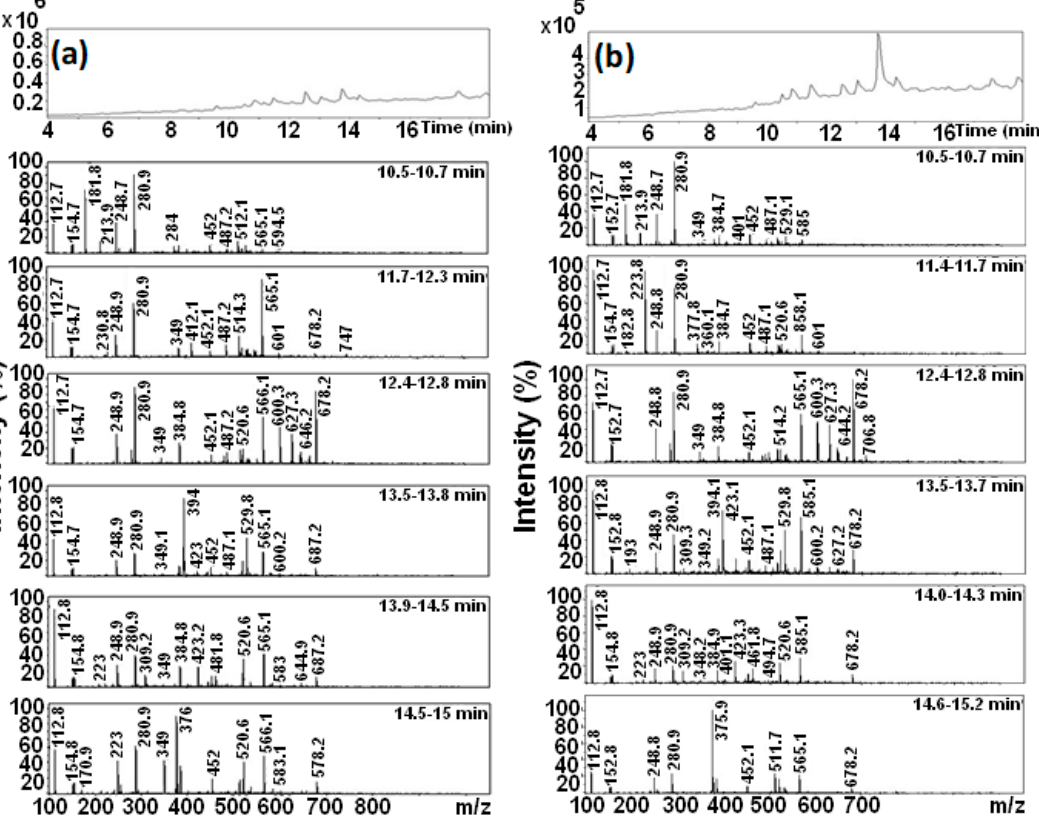
Figure 11. HPLC evolution profiles after degradation of the RB5 dye and mass spectrum of peaks from 10.5 to 15.2 min of the MA powders: ( a ) Mn-Al-Fe and ( b ) Mn-Al-Co.